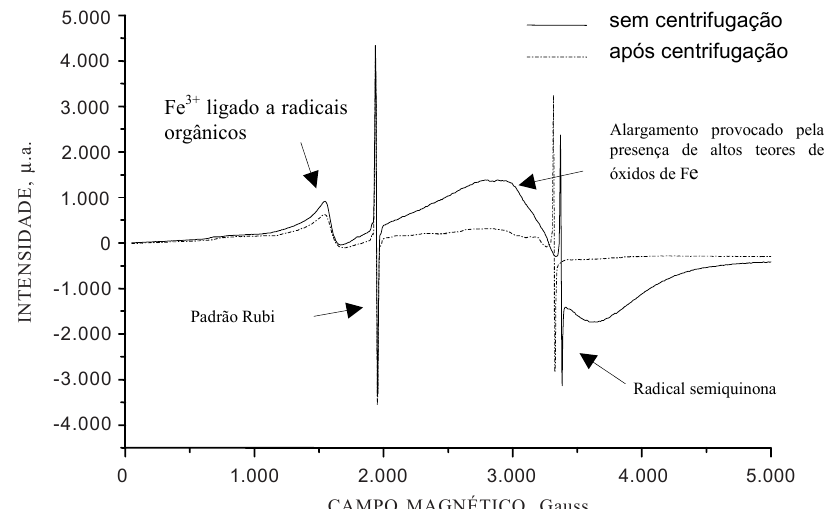
CAMPO MAGNÉTICO, Figura 2. Espectro de RPE de amostras sólidas de AH, extraído da camada de 0,00–0,10 m, do Local I, antes e depois da centrifugação de 12.500 rpm por 3 h. I = intensidade.